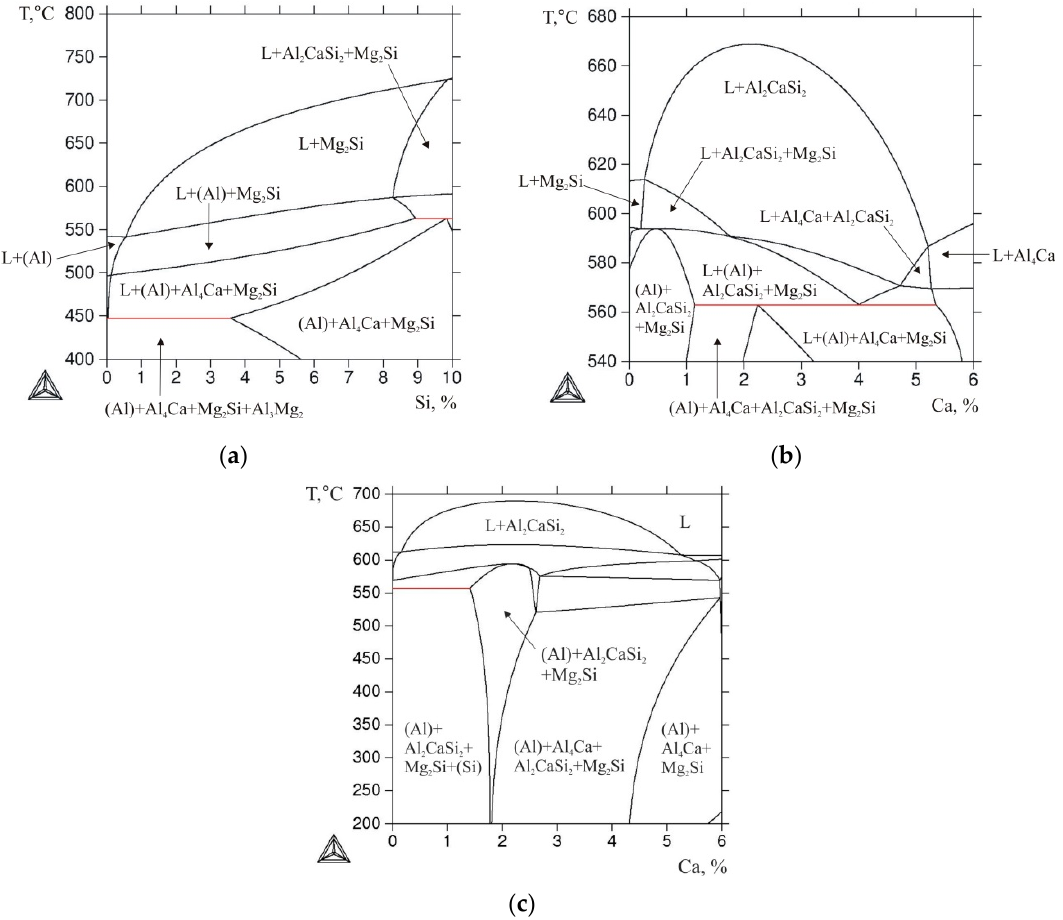
Figure 3. The calculated vertical cross sections of system Al-Ca-Mg-Si: ( a ) at 20% Mg and 1% Ca; ( b ) at 10% Mg and 84% Al (Ca + Si = 6%); ( c ) at 3% Mg and 91% Al (Ca + Si = 6%).